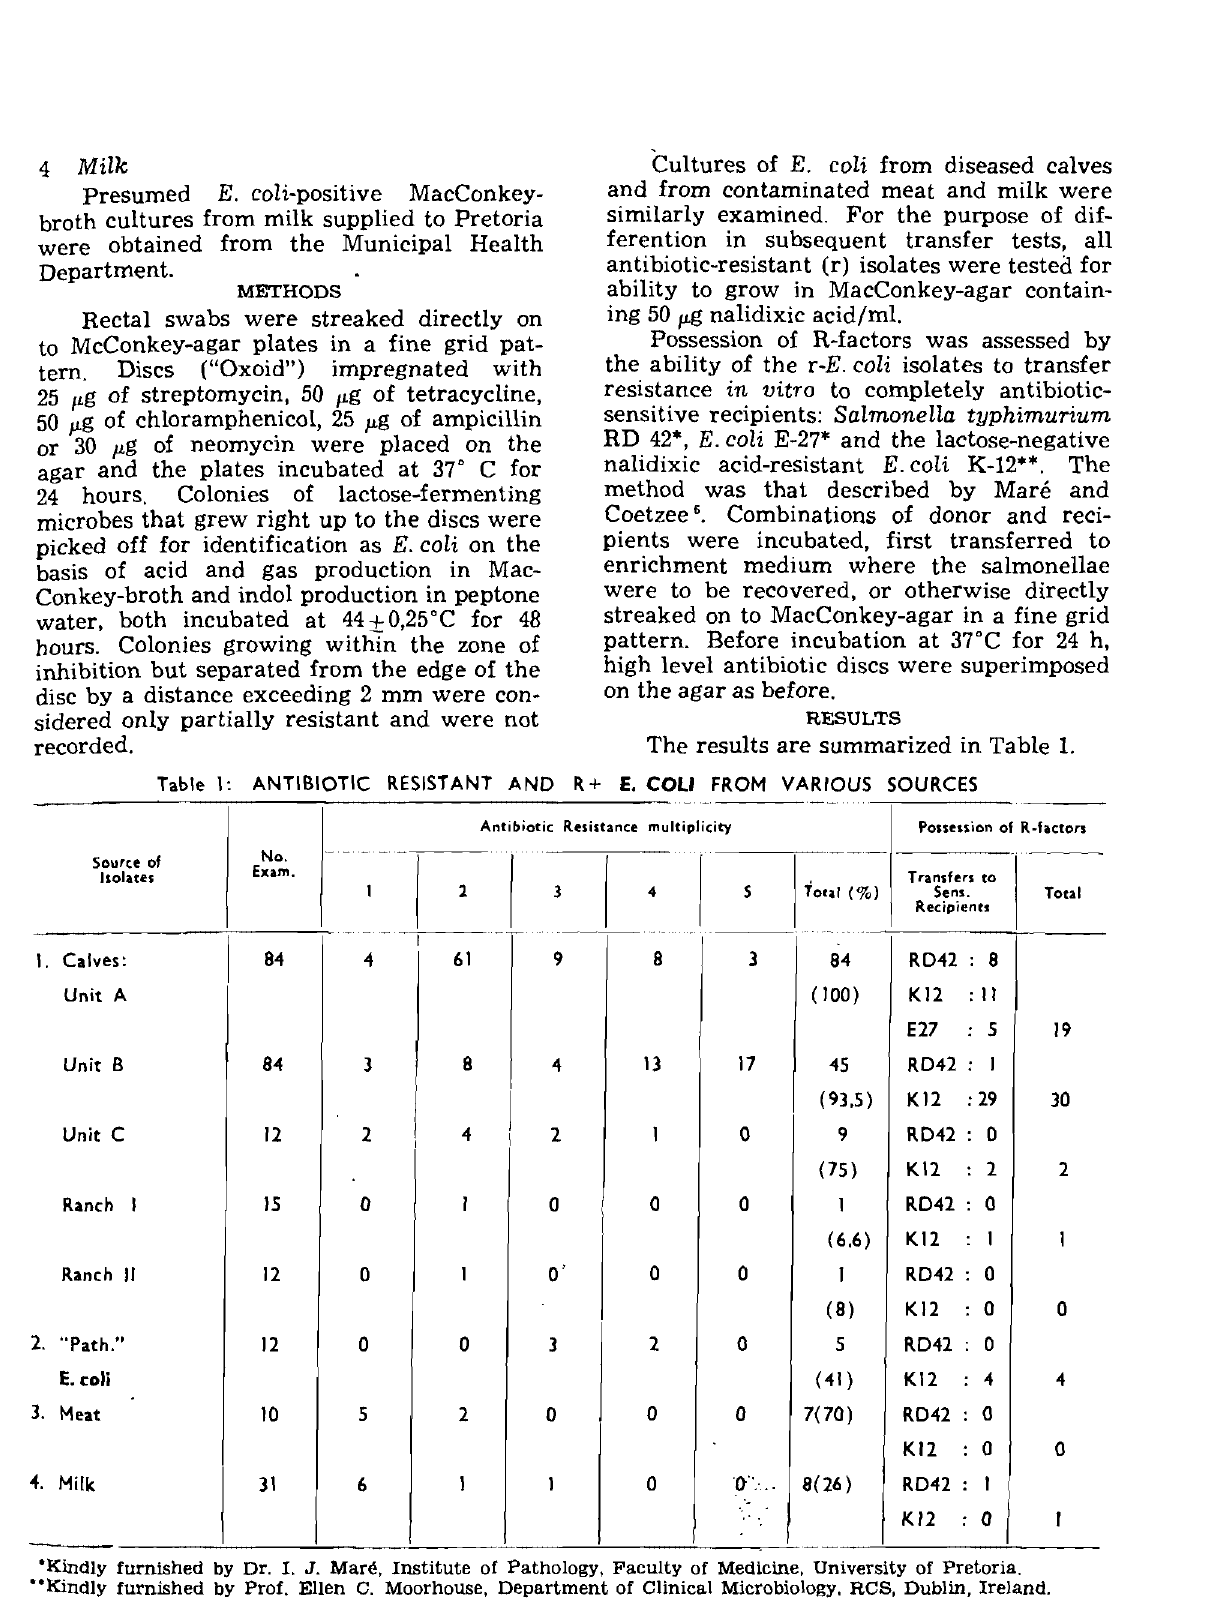
Table I: ANTIBIOTIC RESISTANT AND R+ E. COLI FROM VARIOUS SOURCES Antibiotic Resistance